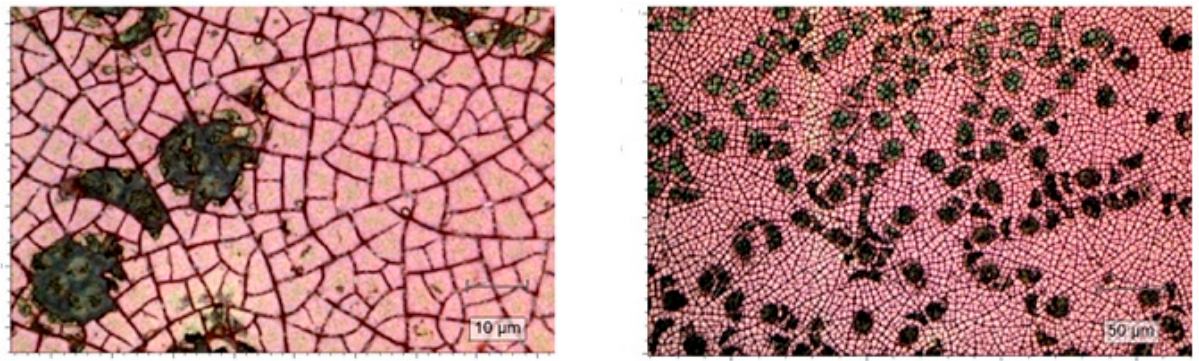
Figure 4. Micrographs of titanium-promoted hematite film samples at different magnification.